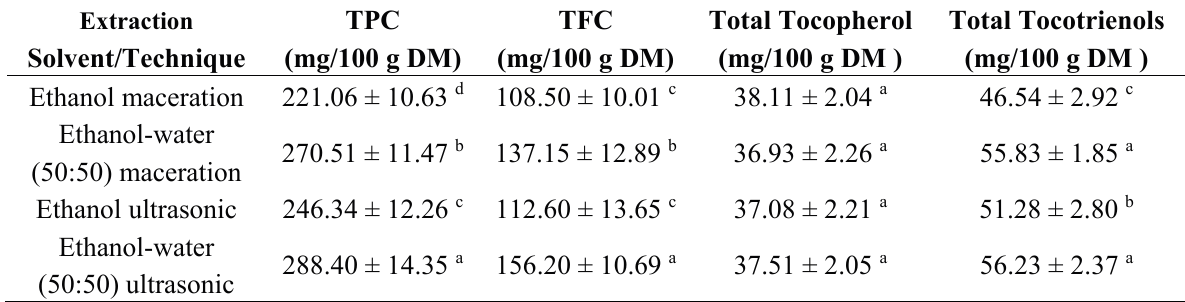
Table 1. Total phenolic, total flavonoid and total tocopherol content of Hashemi rice bran extract with different extraction